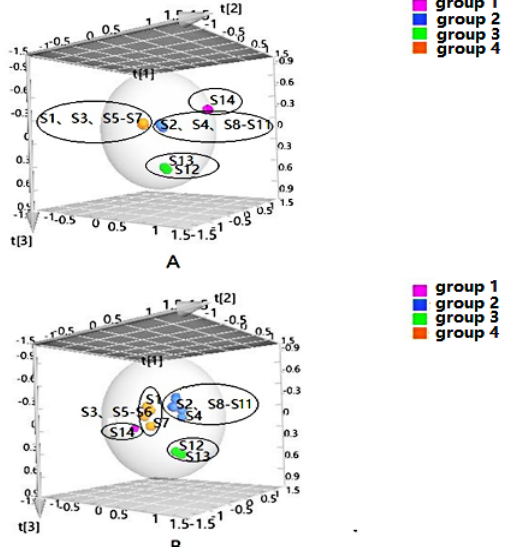
Figure 2. Partial-least-squares discriminate analysis (PLS-DA) of Cortex Periplocae from different producing areas, under the mode of positive ( A ) and negative ( B ) ions.